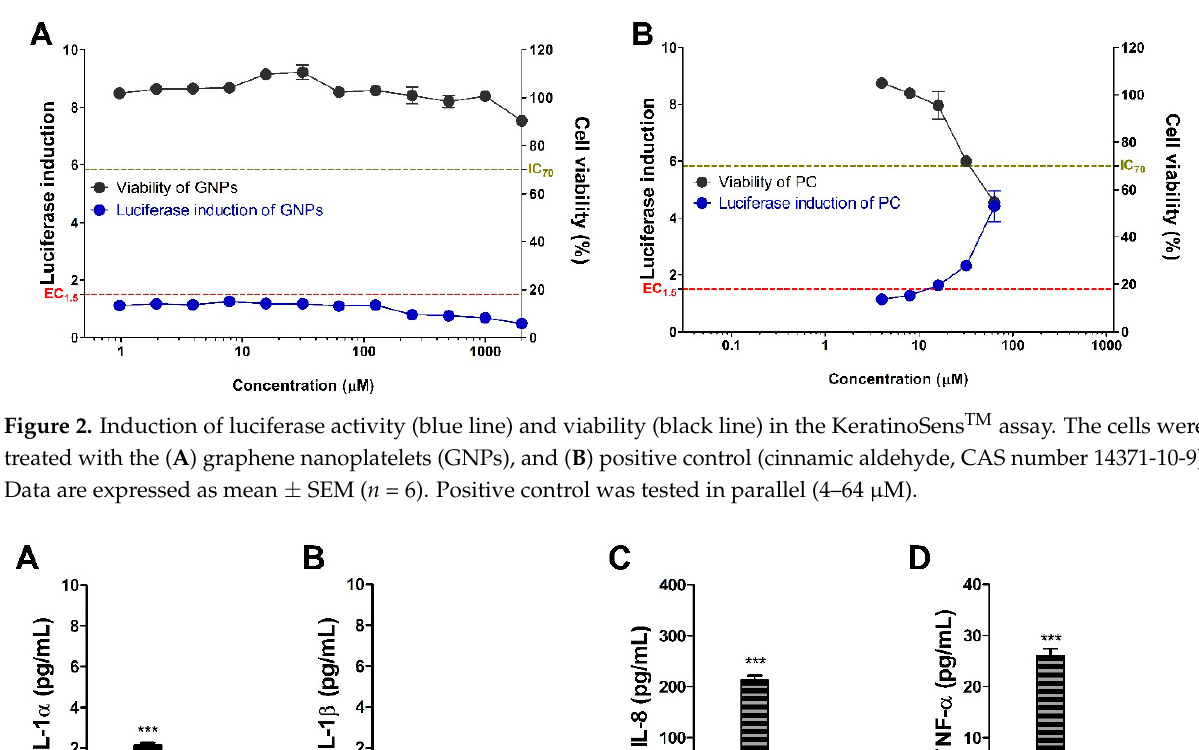
Figure 2. Induction of luciferase activity (blue line) and viability (black line) in the KeratinoSens TM assay. The cells were treated with the ( A ) graphene nanoplatelets (GNPs), and ( B ) positive control (cinnamic aldehyde, CAS number 14371-10- 9). Data are expressed as mean ± SEM ( n = 6). Positive control was tested in parallel (4–64 µM). Table 3. GNPs evaluated in KeratinoSens TM assay.